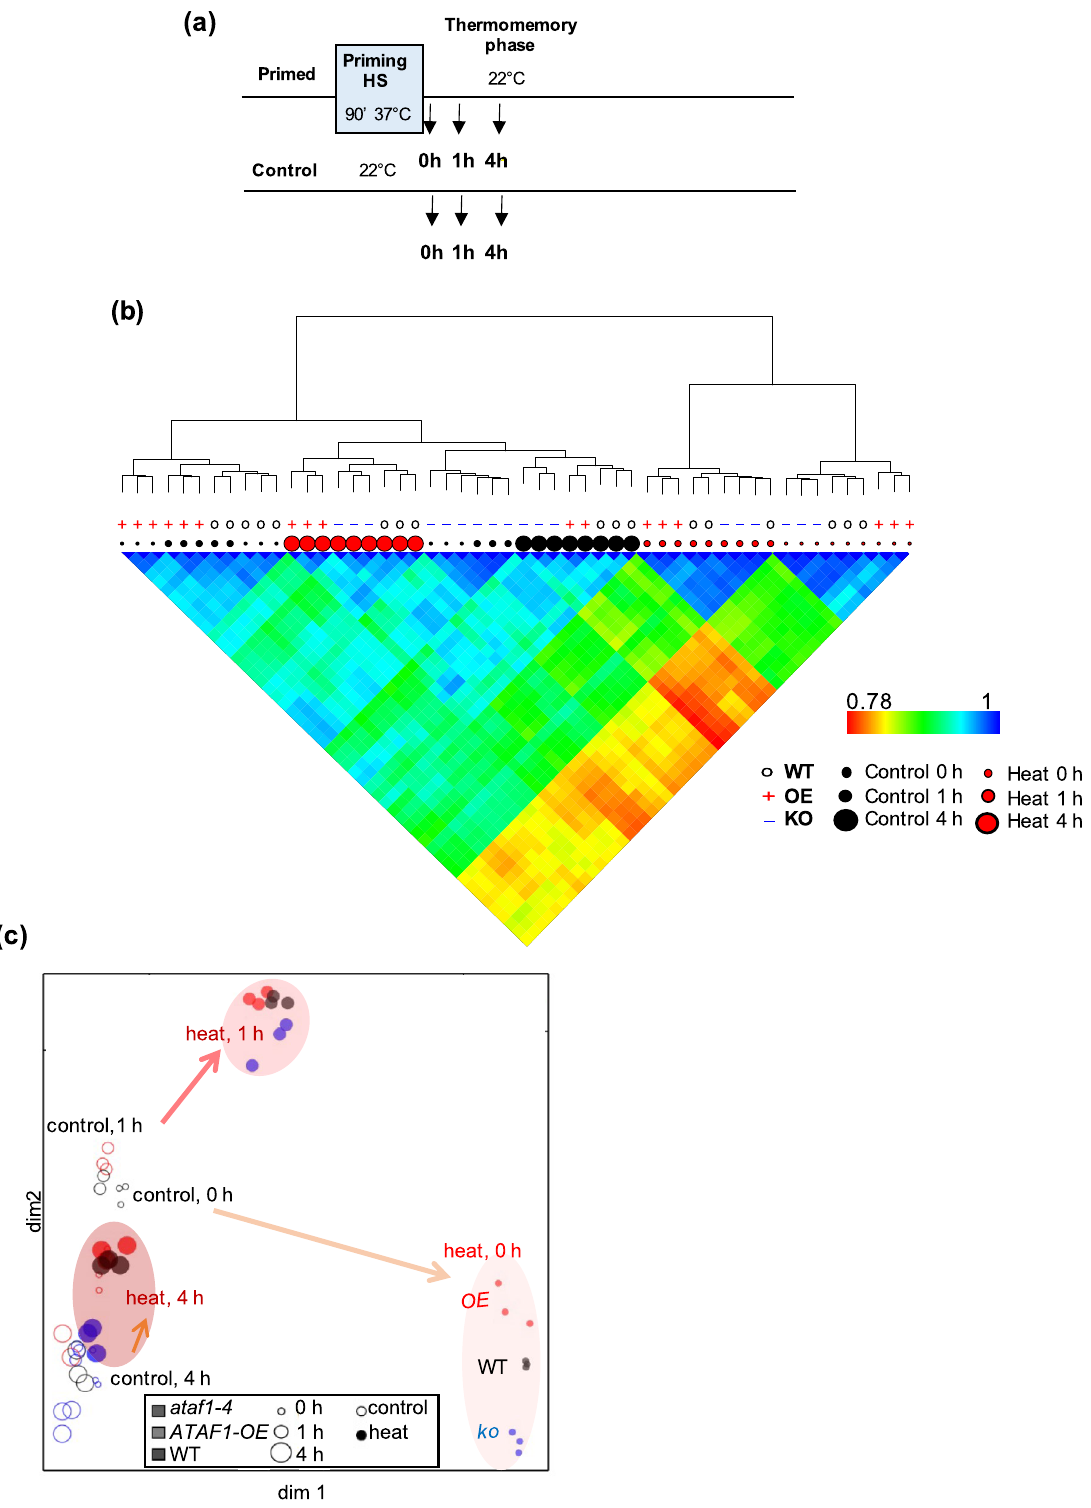
Figure 4. Clustering of RNA-seq data. ( a ) Schematic presentation of the time points used for expression analysis by RNA-seq. ( b ) Top: Hierarchical clustering of the samples according to their expression patterns. “+” denotes ATAF1 -OE lines; “0” denotes wild-type Col-0; and “−” denotes ataf1–4 . The sizes of the circles indicate the time elapsed since HS (0, 1, and 4 h after heat stress). The black and red colors indicate whether the plants underwent control or heat temperature treatment for 90 min. Legend: colored heat map of Pearson’s coefficients of expression profiles between all possible pairs of the samples. A partial rainbow color scheme, from red to blue, indicates the range of correlation values. ( c ) Multidimensional scaling (MDS) plot. Overall similarities and differences between samples, based on a multidimensional scaling analysis. Briefly, the Euclidean distance between all samples was calculated according to the expression levels of all genes, and represented in a two-dimensional